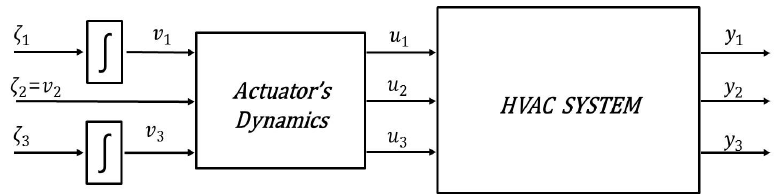
Figure 3. Concept of the dynamic extension algorithm